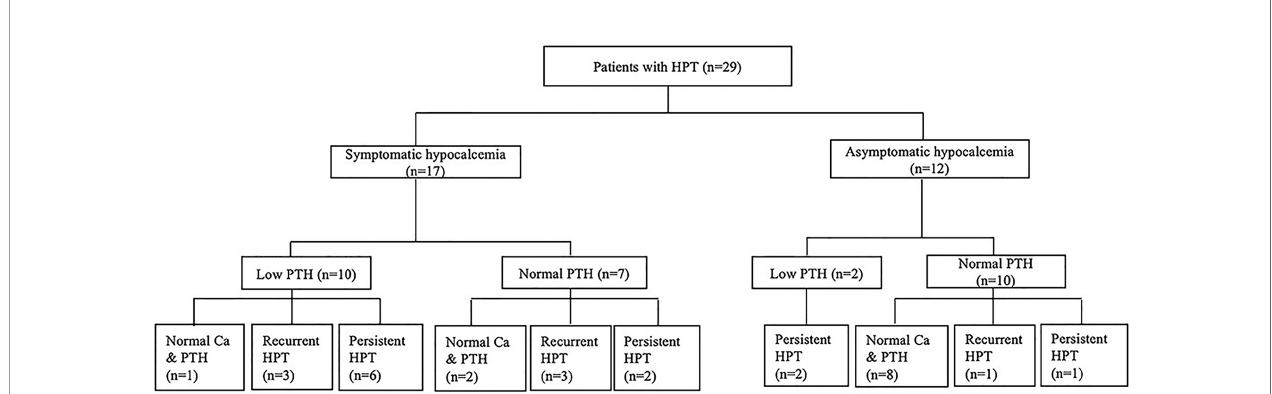
FIGURE 2 | The evolution of parathyroid status in children with 22q11.2 deletion syndrome. Ca, serum calcium level; HPT, hypoparathyroidism; PTH, parathyroid